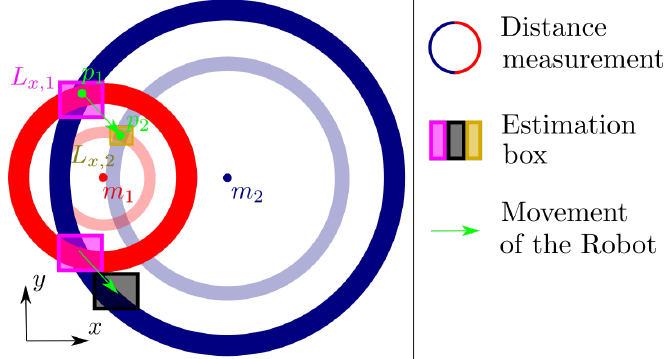
Figure 10. Situation where several sets are solution to the interval